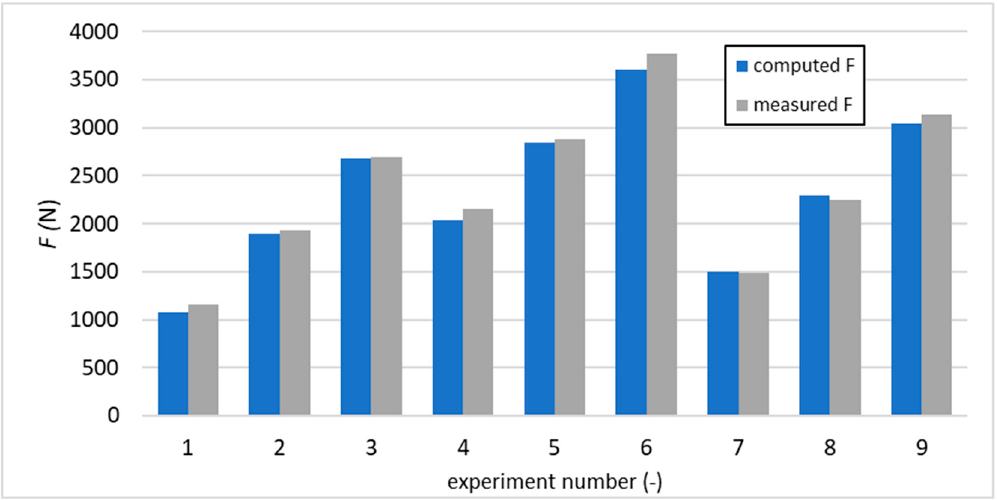
Figure 11. Graphical comparison of predicted and measured values of total machining force F .